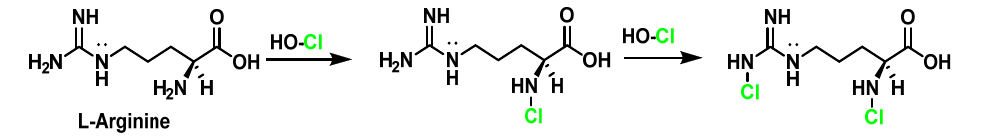
Figure 29. Summary of products of oxidation of Cys and Cystine residues by HOCl. Cysteine can also react with N -Cl-taurine to generate sulphenyl chloride, as shown in Figure 30.